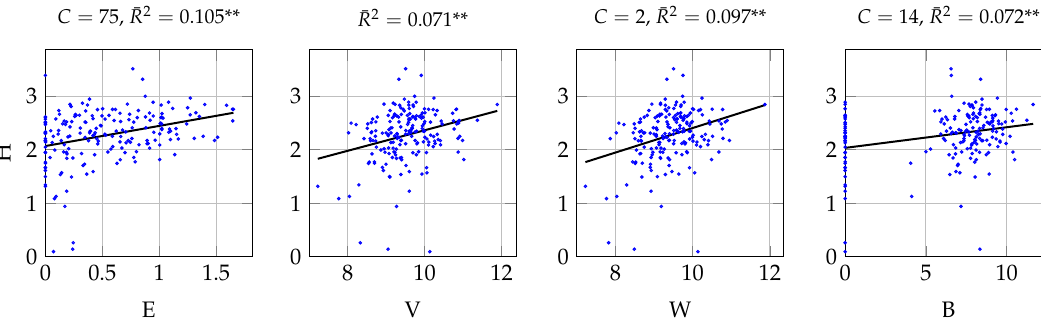
Figure 10. Shannon index (H) best univariate linear correlations with different SH measures (E: entropy, V: log-transformed global variability or MDC, W: log-transformed within-class variability, B: log-transformed between-class variability) computed from multitemporal data. C is the corresponding number of clusters, ¯ R 2 is the adjusted coefficient of determination and ** signifies p -value <0.001. The black line is the linear regression